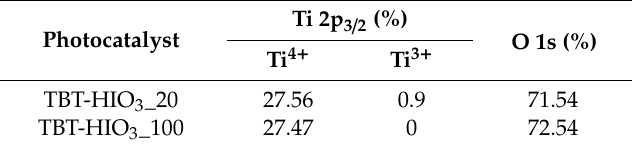
Table 6. Fraction of oxidation states of Ti as well as surface composition of the selected defected TBT-HIO 3 photocatalysts determined by X-ray photoelectron spectroscopy analysis.